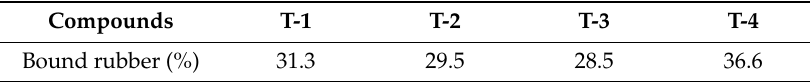
Table 8. Bound rubber content of the T-1 to T-4 compounds.